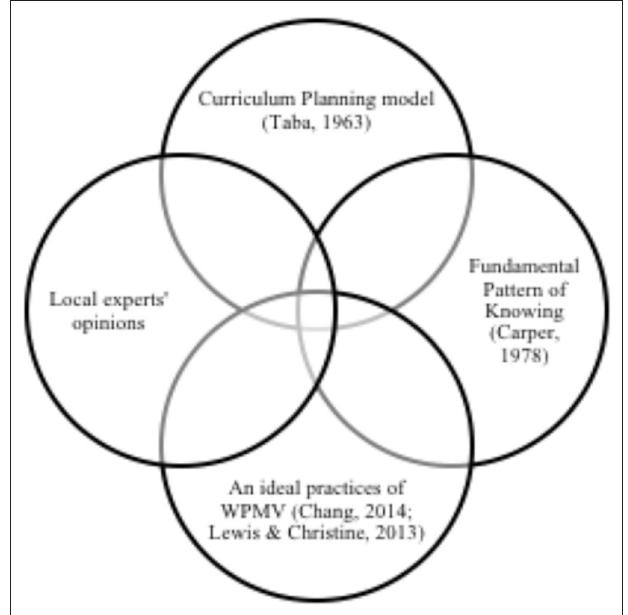
FIGURE 3 | MPVP pedagogy for the Malaysian